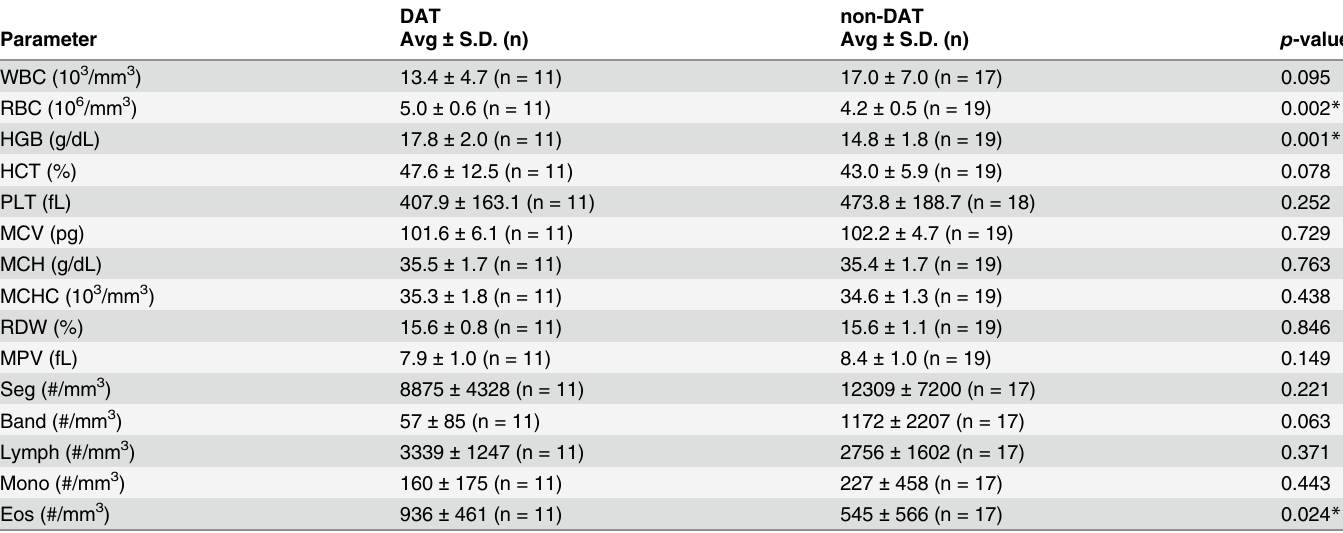
Table 2. Hematological parameters of the training set.